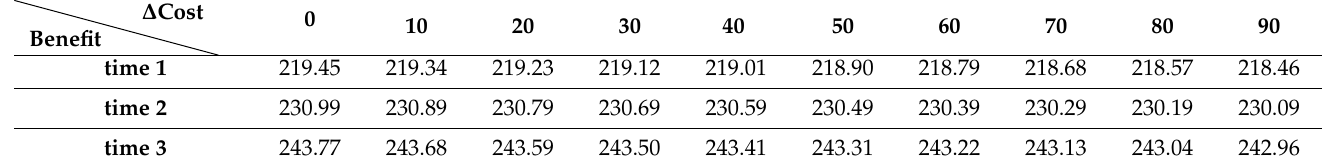
Table 5. ∆ cost and total